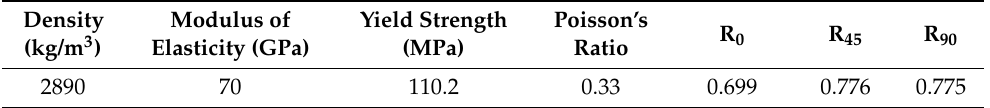
Table 1. Properties of SA5182 (AA5182-O) [23,24].